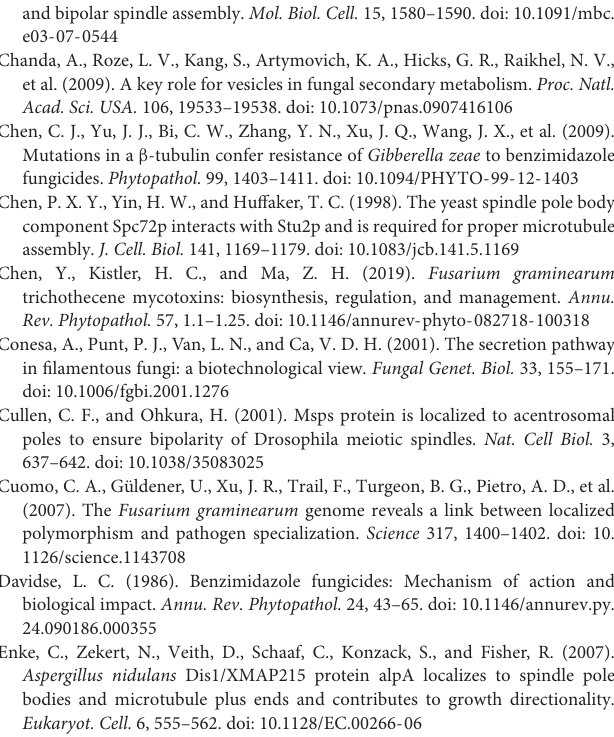
alignment was performed using the online service (www.genome.jp/tools-bin/ clustalw). The alignment images were generated by the online service of ESPript